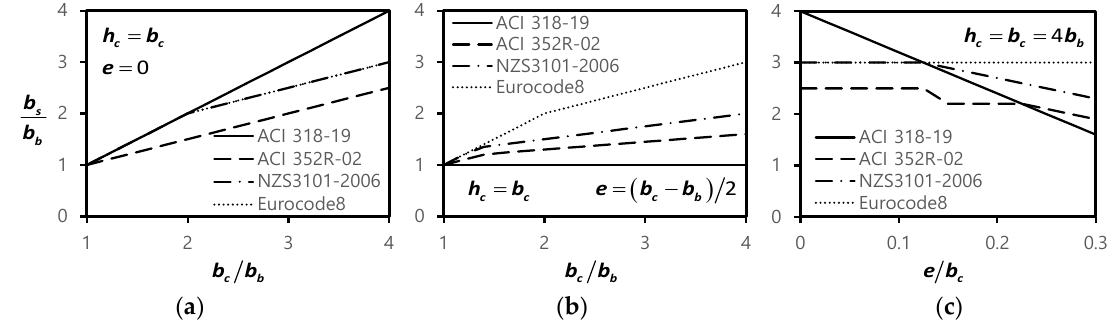
Figure 2. Comparison of effective joint widths in current design codes: ( a ) concentric beam–column joint; ( b ) eccentric beam–column joint; ( c ) effect of beam eccentricity.